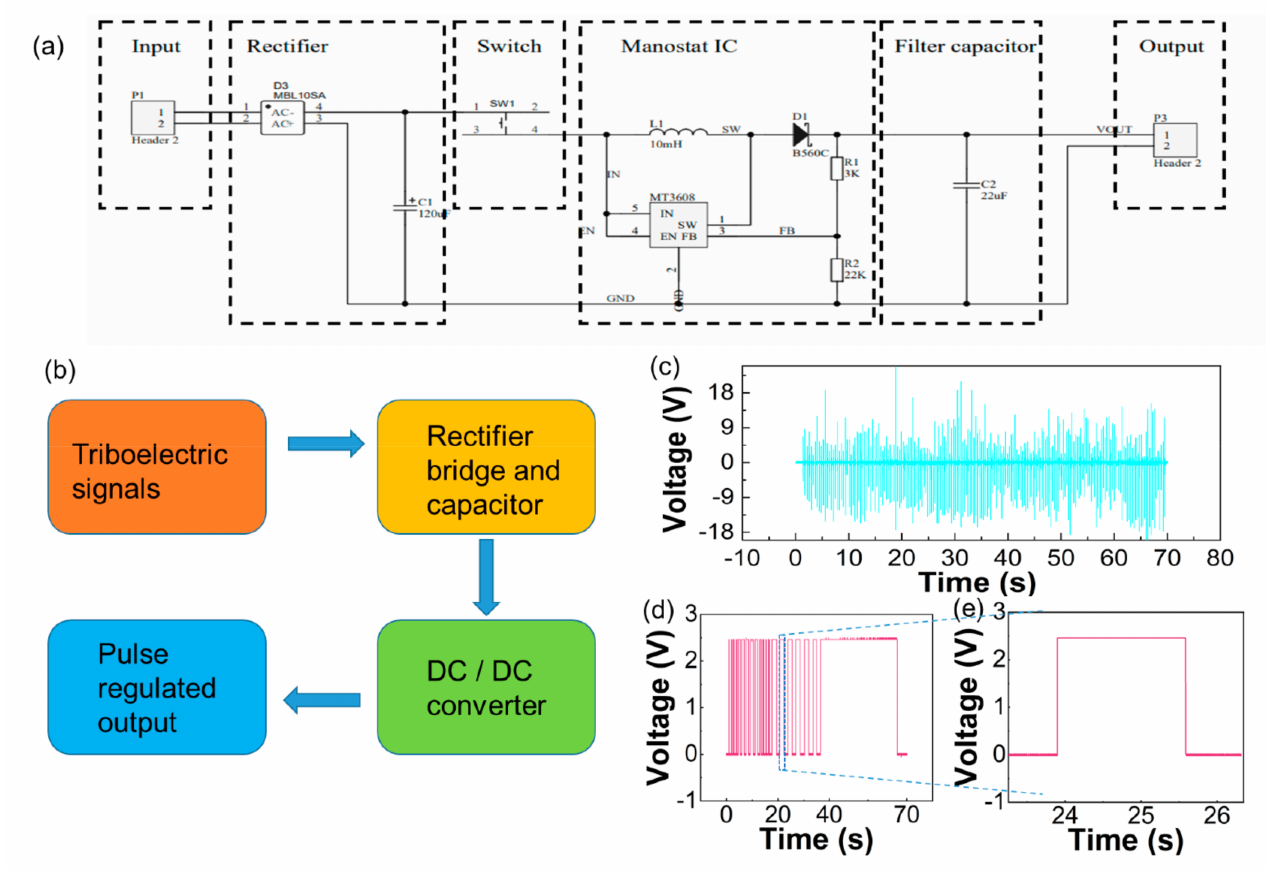
Figure 3. The low-frequency voltage stabilizing output device. ( a ) The circuit diagram of the device. ( b ) The low-frequency voltage stabilizing output device working modules. ( c ) The untreated friction voltage. ( d ) The output voltage of low- frequency voltage stabilizing output device. ( e ) Output